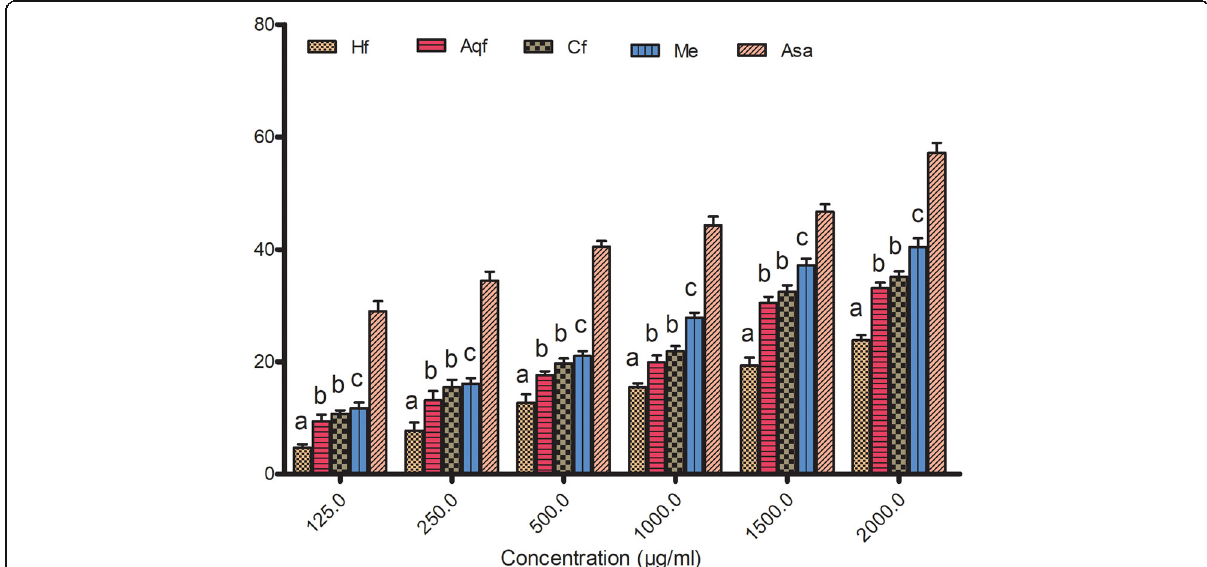
Fig. 2 ABTS free radical scavenging capability of the rhizome of Sorghum halepense (L.) Pers methanolic extract and its fractions. Aqf: aqueous fraction, Cf: chloroform fraction, Hf: n -hexane fraction and Me: methanolic extract Asa: ascorbic acid. The scavenging effect of extract and ascorbic acid were compared. c indicates significance at p < 0.05, b at p < 0.01 and a at p < 0.001 (Dunnett ’ s-test). Performed the experiments in triplicate ( n = 3)